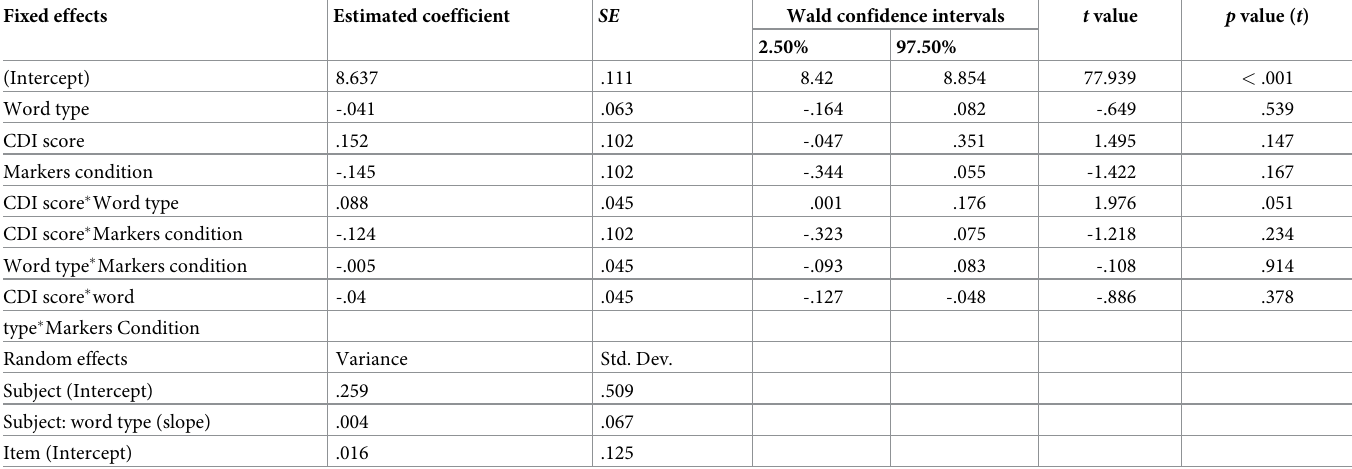
Table 3. Summary of the linear mixed-effects model of (log transformed) looking times on the segmentation trials for participants in experiment 1 (with median split for vocabulary size). Fixed